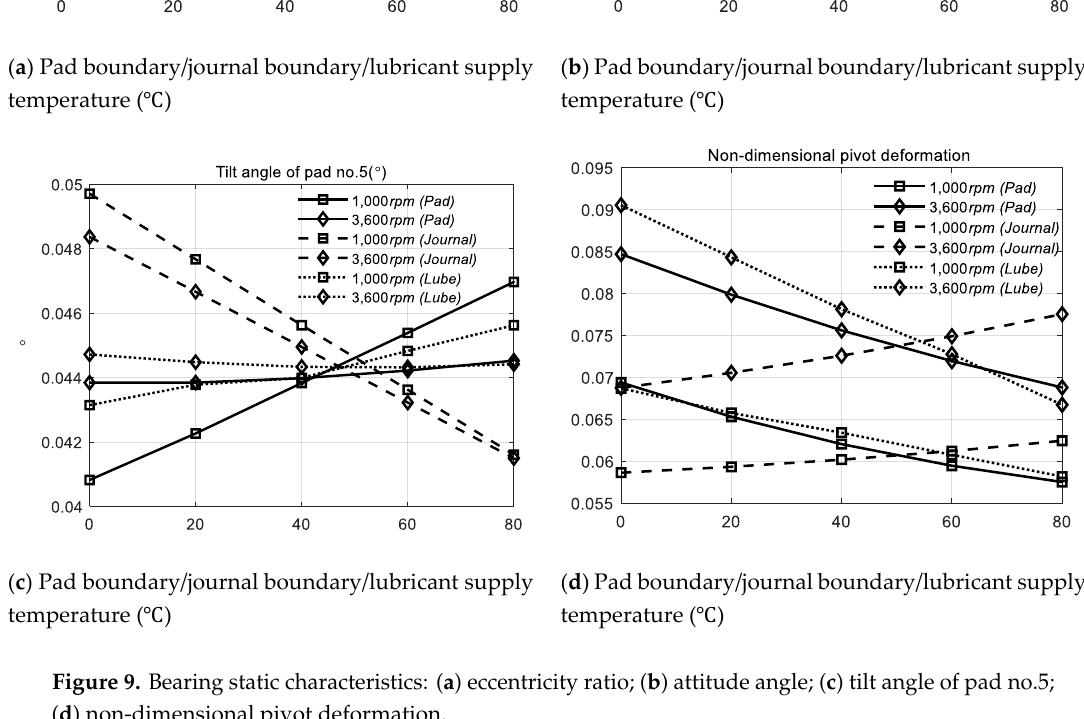
Figure 9. Bearing static characteristics: ( a ) eccentricity ratio; ( b ) attitude angle; ( c ) tilt angle of pad no.5; ( d ) non-dimensional pivot deformation.